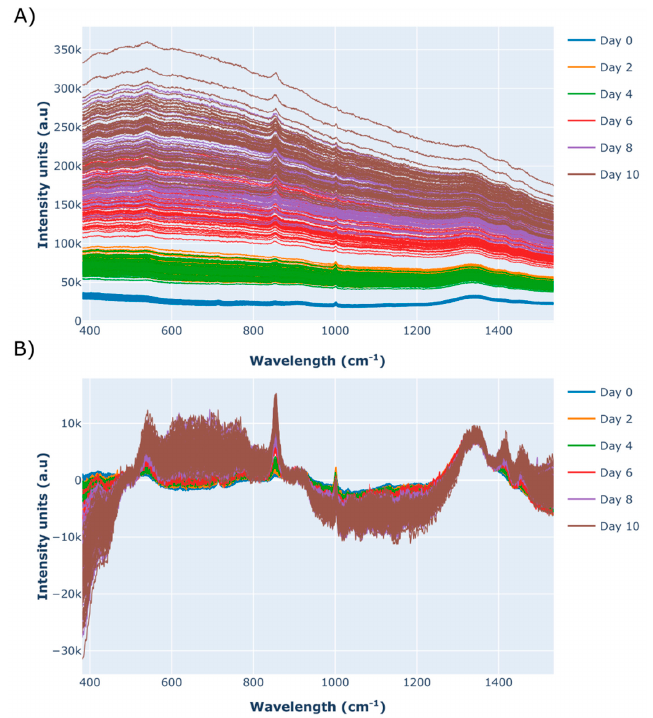
Figure 3. Raman spectra recorded by the high-throughput Raman spectroscopy microscope for each of the 24 micro-bioreactor cell culture runs on day 0–10 shown in the form of ( A ) the raw spectral data and ( B ) the baseline-corrected spectra, using a 1st order polynomial function followed by the application of a standard normal variate (SNV) scattering scatter algorithm and a Savitzky–Golay smoothing filter. Each spectrum was generated using 5 accumulations each with a 30 s acquisition time, recorded using 10% laser power (30 mW). Four separate PLS models were developed to correlate the pre-processed spectra shown in Figure 3B to the concentrations of glucose and lactate, VCD, and the antibody concentration. The